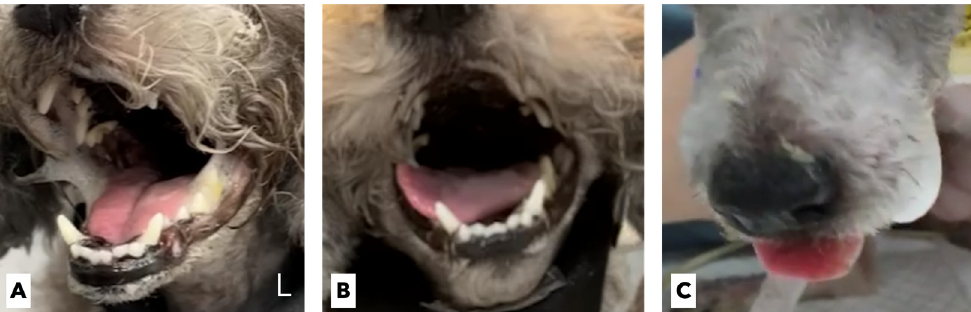
Figure 2. Gross images of the tongue over time. ( A ) The patient is not able to protrude or move its tongue, and hypersalivation is identified. ( B ) On the 6th postoperative day, the tongue is gradually protruding to the right lateral side. ( C ) Twenty days after revision surgery, there is significant improvement in the tongue movement, with the tip of the tongue reaching the lip area.